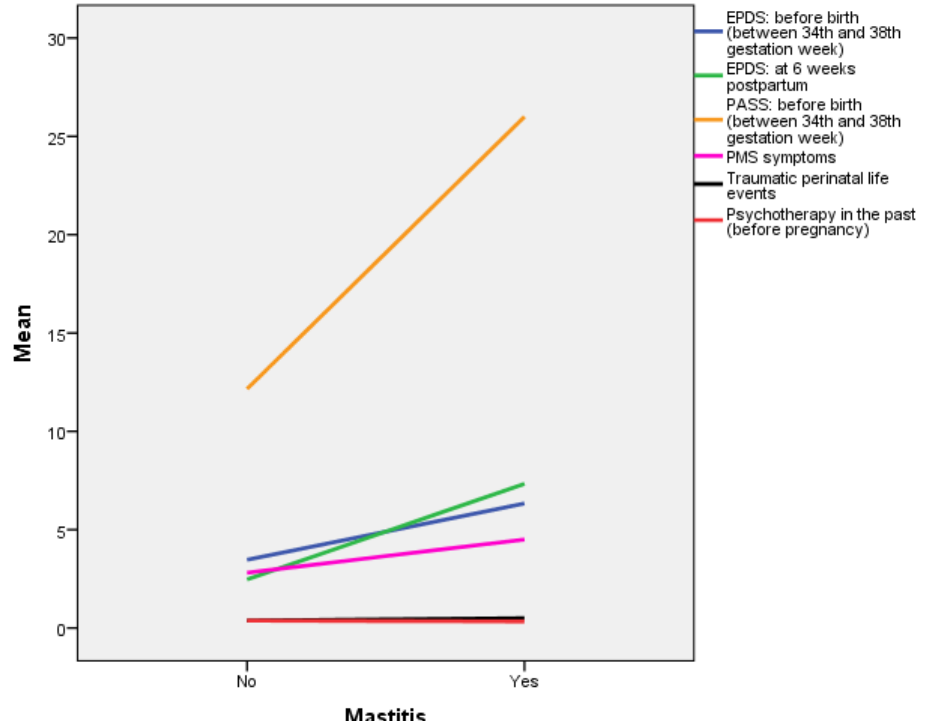
Figure 2. Mean values of the independent variables that seem to predict lactation mastitis. * The variables “traumatic life events” and “psychotherapy in the past” cannot be adequately demonstrated in Figure 1 because they are dichotomous. in Figure 1 because they are